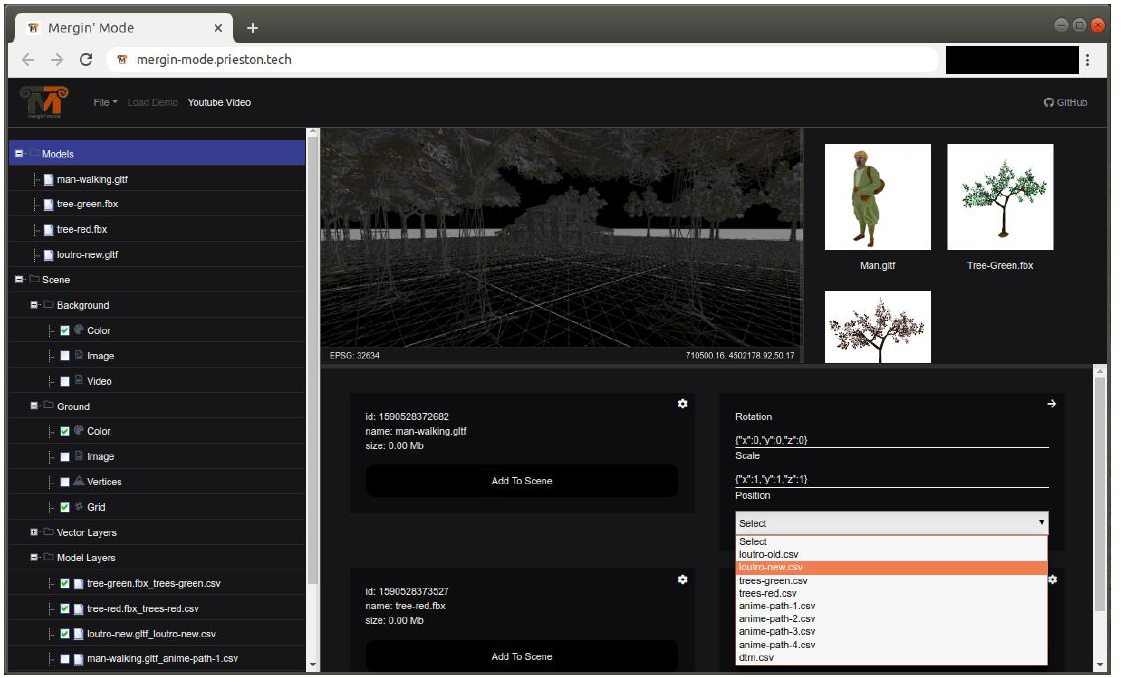
Figure 6. 3D stable models representing trees from the website Turbosquid, available online: https: // www.turbosquid.com / (accessed on 8 May 2020) and a virtual human with clothes belonging to the Ottoman period.